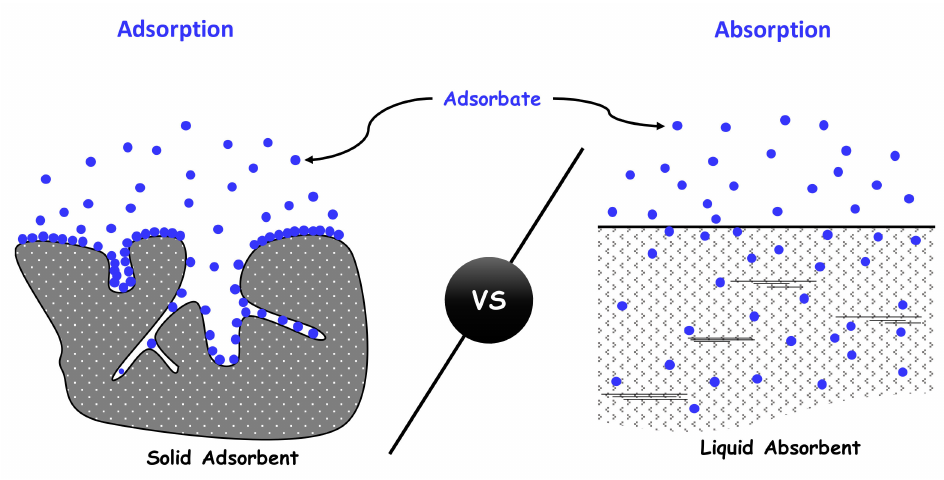
Figure 3. Adsorption vs. absorption: difference and